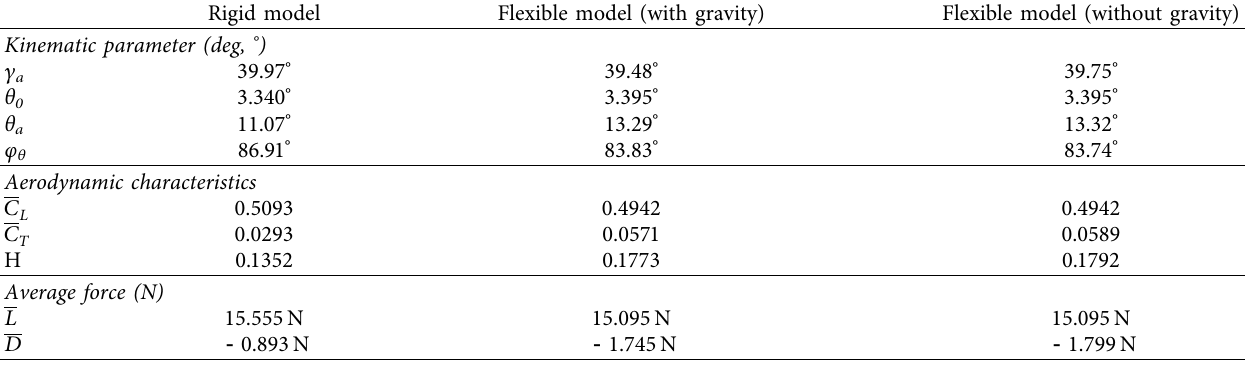
Table 4: Optimal kinematics results from the DIRECT algorithm.